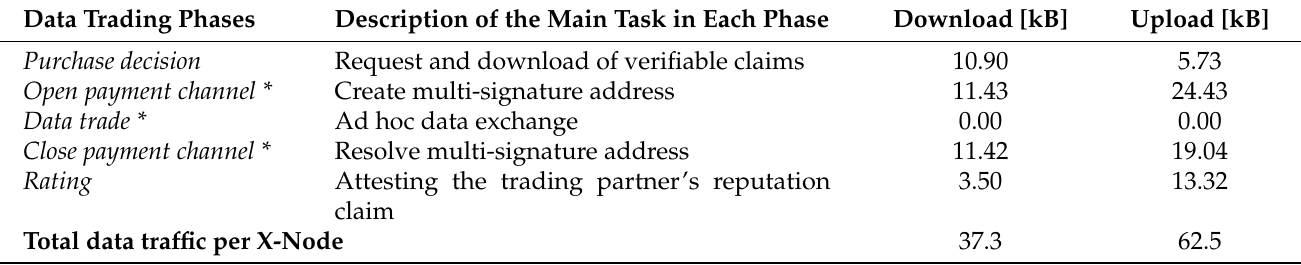
Table 2. Average data traffic between a single X-Node and the IOTA Tangle during a data trading session. Data Trading